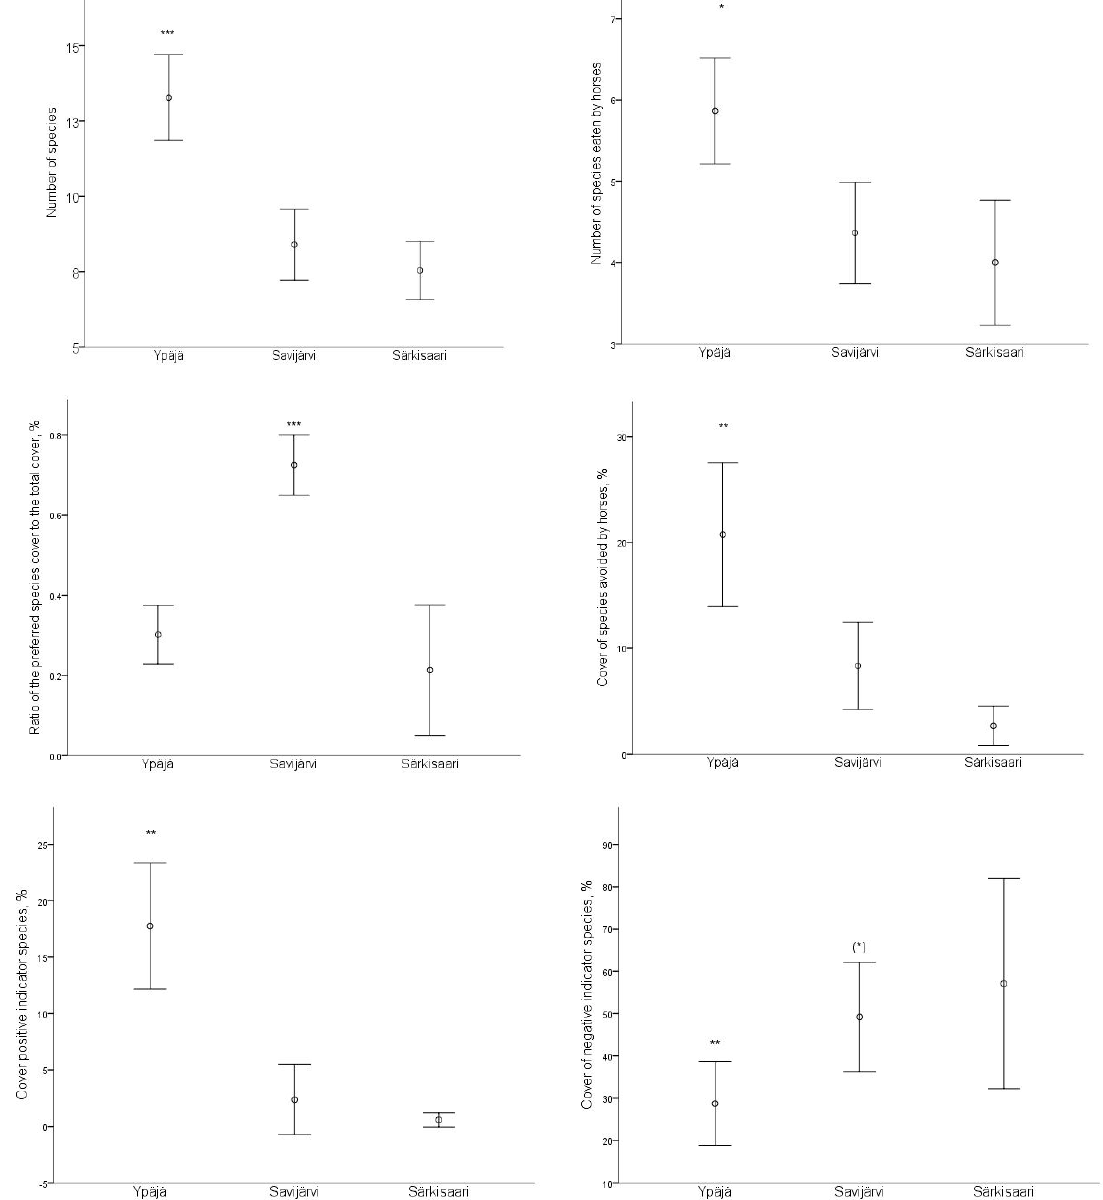
Figure 1. Number of vascular plant species, number of species eaten by horses, ratio of the cover of species preferred by horses related to the total vegetation cover, cover of plant species avoided by horses, and numbers of positive and negative indicator species per 1 m 2 for mesic grasslands by the study areas (mean and ± SE). Sample sizes are: n = 44 (Ypäjä), n = 33 (Savijärvi), n = 9 (Särkisaari). Statistical differences are based on generalized linear model (* p < 0.05, ** p < 0.01, *** p < 0.001, and (*) p < 0.1.)